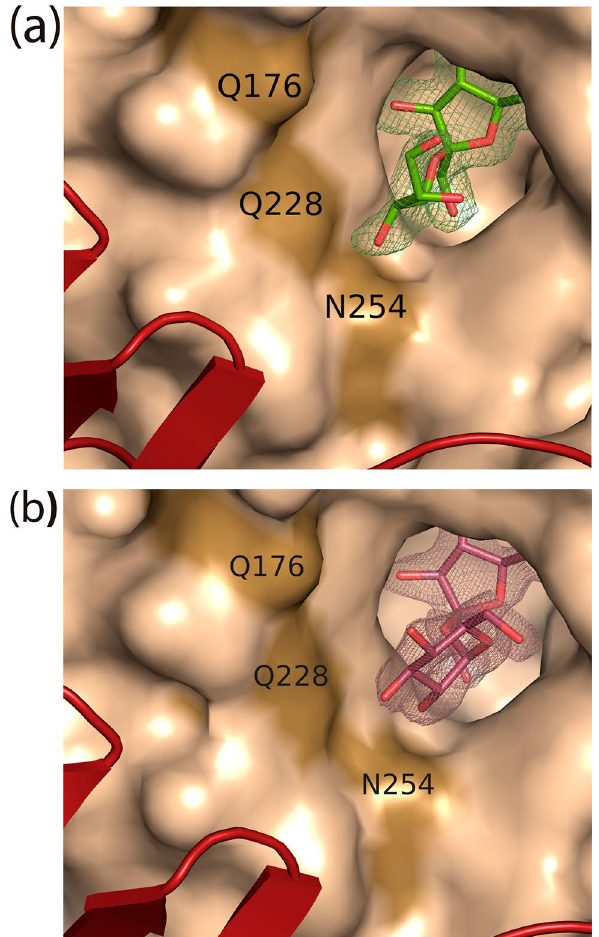
Figure 1. Surface representation of a Ffase-D50A subunit showing the active site complexed with ( a ) fructosyl- erythritol (green) or ( b ) sucrose (prune). The 2FoFc electron density maps are contoured at 1σ. A small part of the second subunit is shown as red